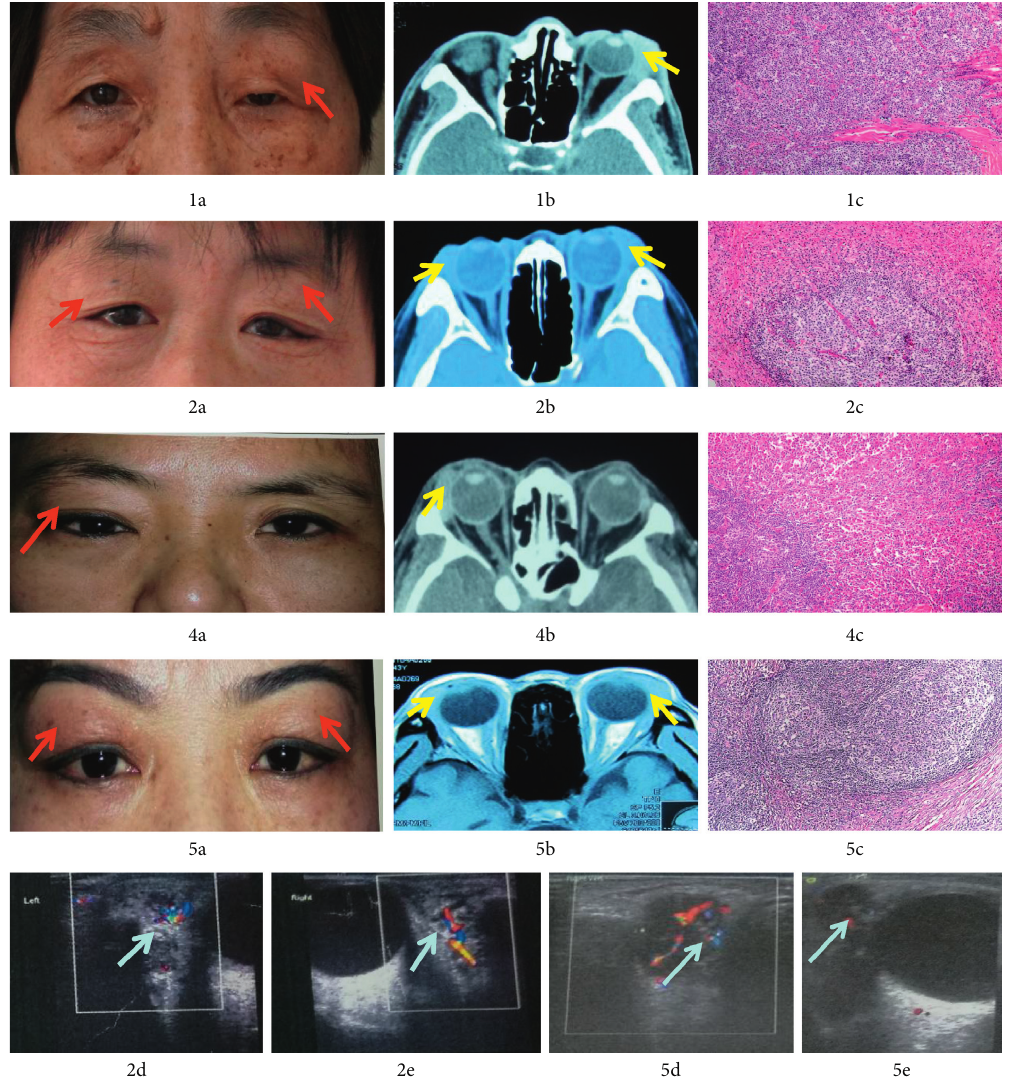
Figure 2: Case 1:1(a) ∼ 1(c), case 2: 2(a) ∼ 2(e), case 4: 4(a) ∼ 4(c), and case 5: 5(a) ∼ 5(e). Preoperative appearance of the eyes (red arrows in 1(a), 2(a), 4(a), and 5(a)). CT/MRI showed swollen masses in the lacrimal gland area (yellow arrows in 1(b), 2(b), 4(b), and 5(b)). Pathological images (1(c), 2(c), 4(c), and 5(c)). Color ultrasonography showed masses in the lacrimal gland area with abundant blood flow (blue arrows in 2(d), 2(e), 5(d), and